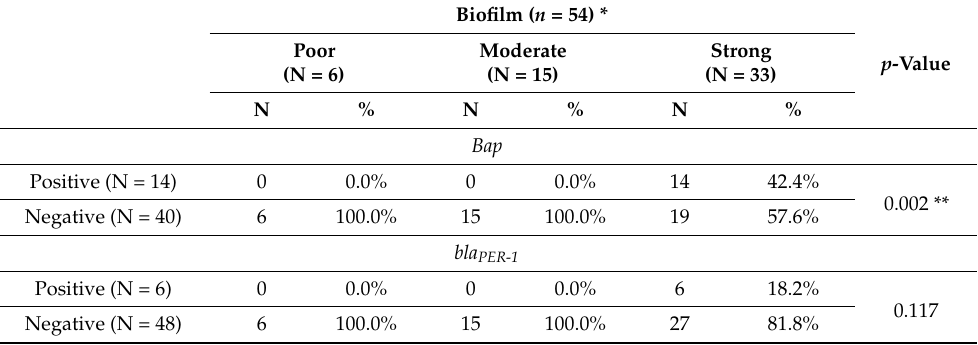
Table 2. Biofilm production (poor, moderate, and strong) among carbapenem resistant Acinetobacter baumannii isolates from ICU patients with pneumonia in relation to biofilm-associated genes ( ompA , bap , and bla PER - 1